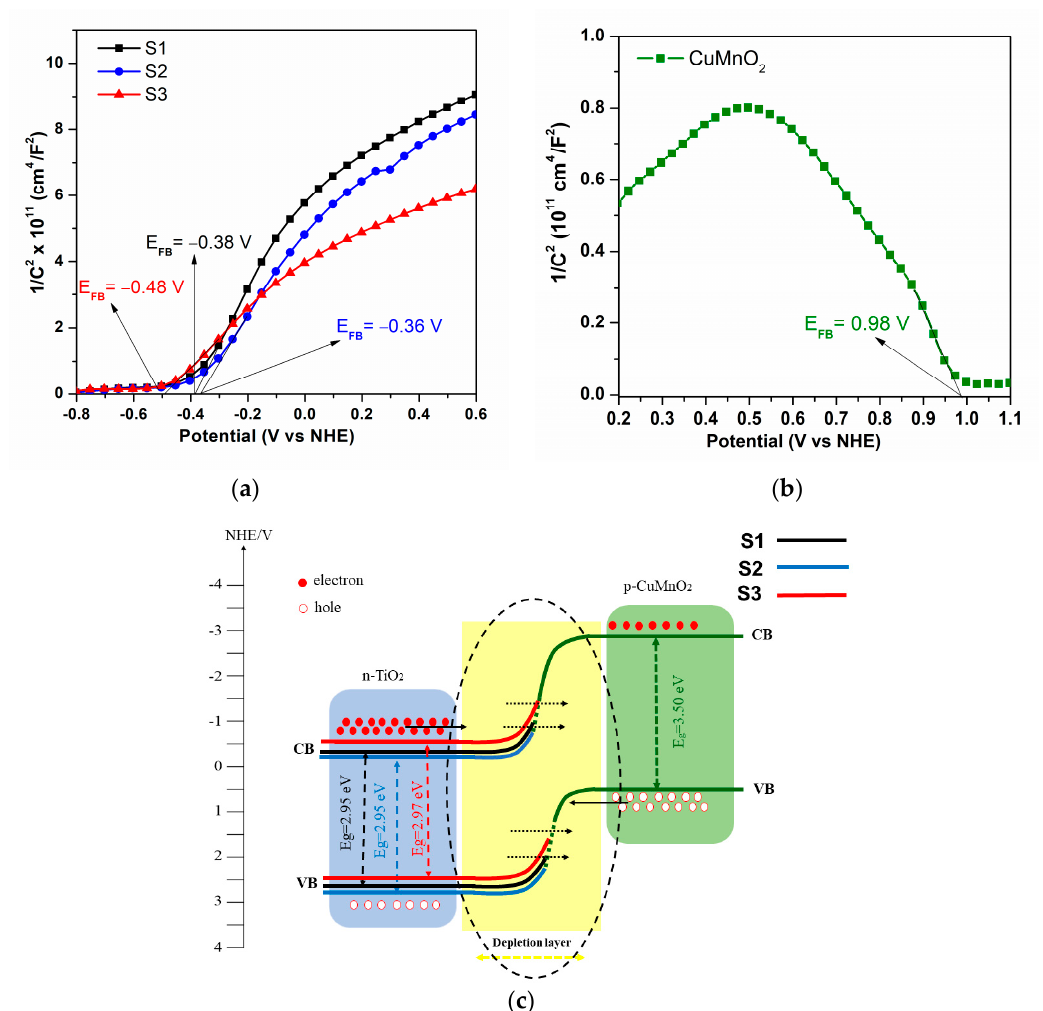
Figure 7. Mott-Schottky analysis of ( a ) Ti-TiO 2 layers and ( b ) CuMnO 2 film; ( c ) diagram for corresponding conduction and valence band edges.